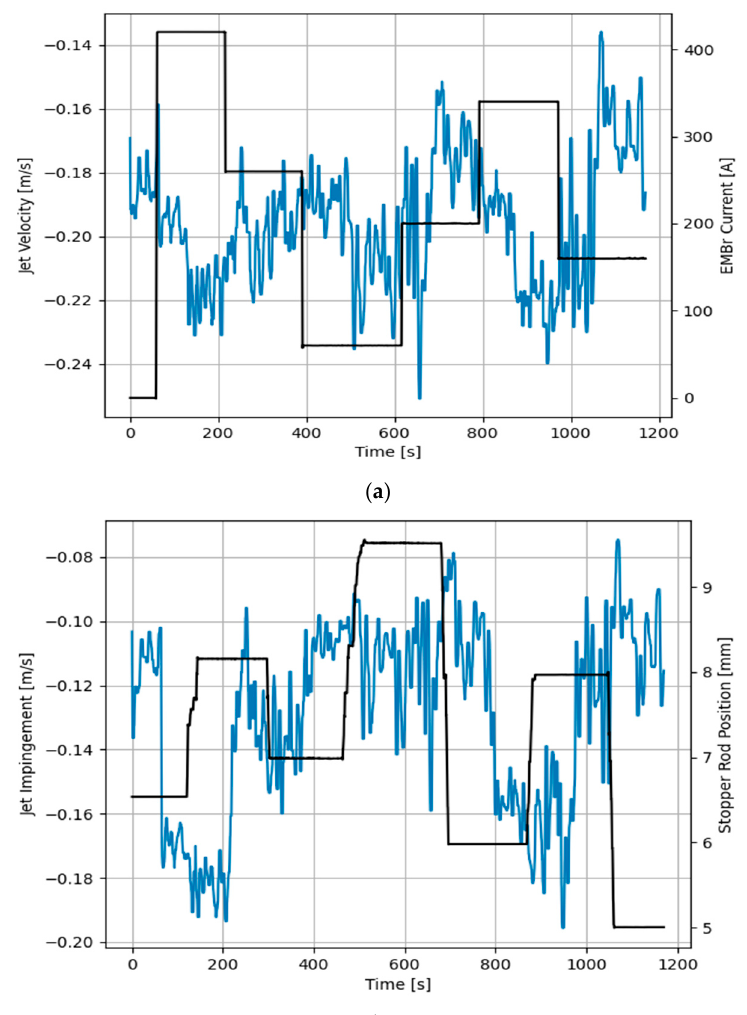
Figure 9. Measured response of jet velocity to both manipulated variables, ( a ) Electromagnetic brake current, ( b ) Stopper rod position.